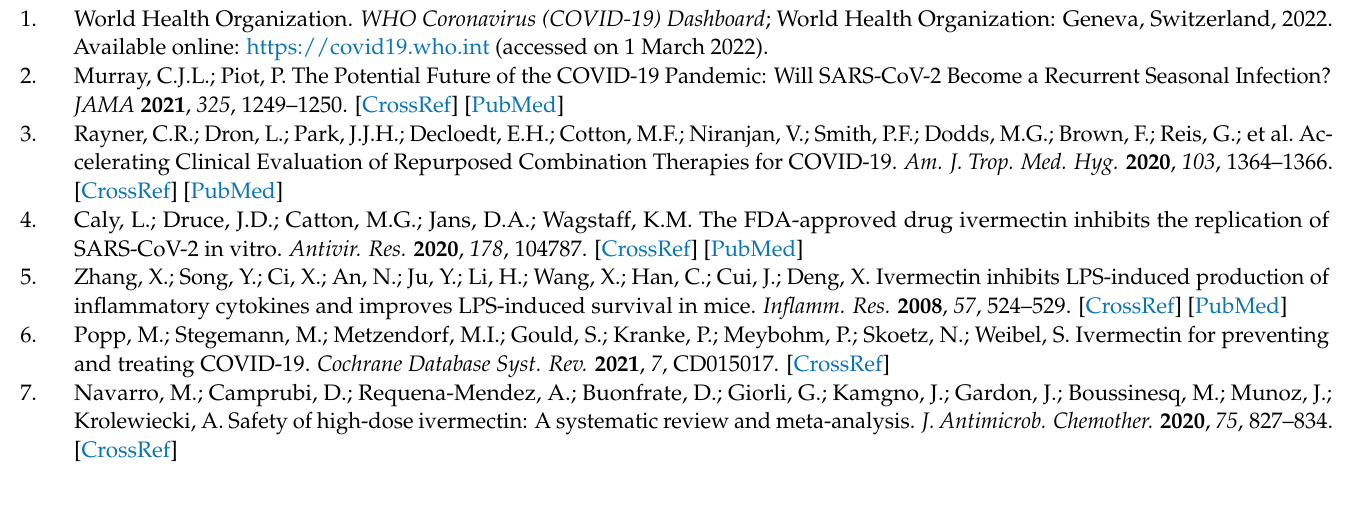
participants; Table S2: Primary outcomes in subgroup population of ivermectin prevention